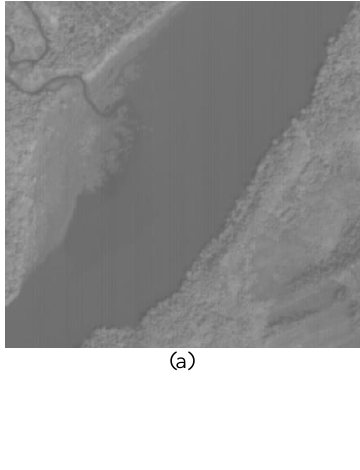
Figure 7 (a)image with proposed method applied,(b) image with moment matching method applied